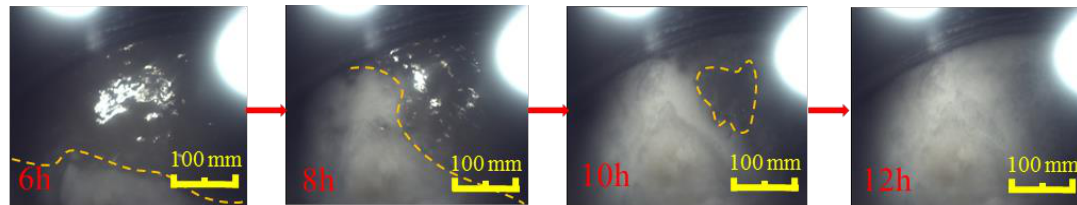
preparation time of the two groups was 19.20 h.